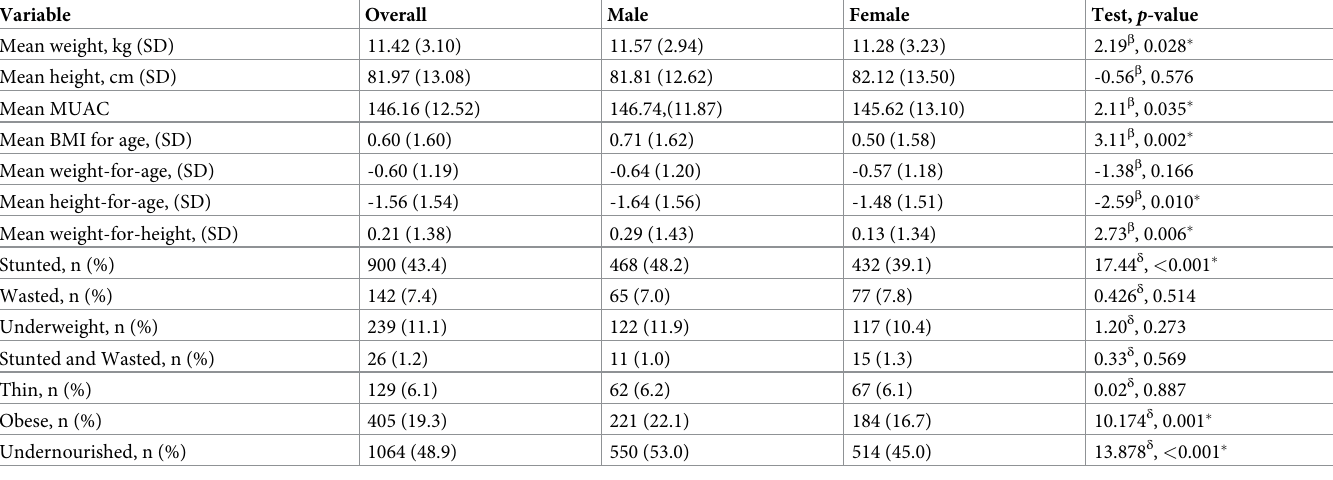
Table 2. Anthropometric characteristics in relation to the sex of study children.